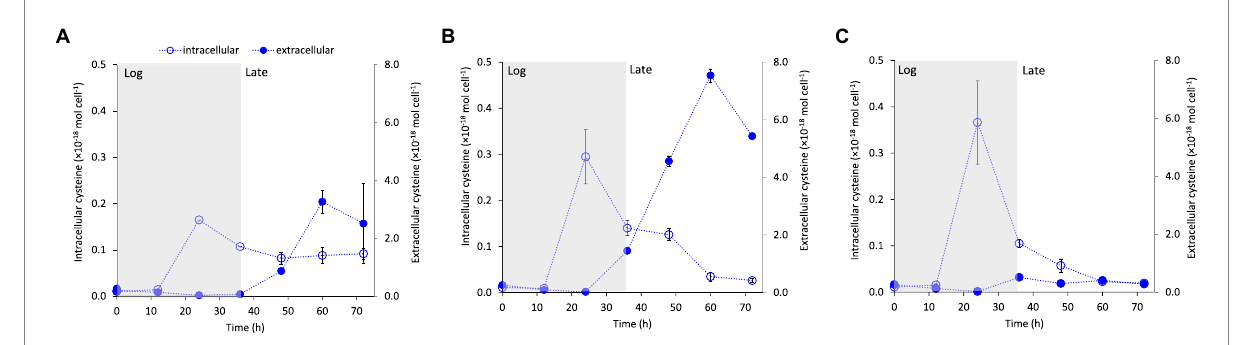
FIGURE 4 Intracellular and extracellular cysteine concentration (mol cell − 1 ) over time of growing G. sulfurreducens cells at added Fe(II) concentrations to the medium of (A) 0.5 μ M, (B) 1.5 μ M and (C) 3.7 μ M. The main growth stages: exponential growth (Log) and late exponential-stationary growth (Late) are indicated by shading in the figure (see Supplementary Figure S3 for growth curves). Error bars represent standard error, n = 3 and are smaller than visible in several